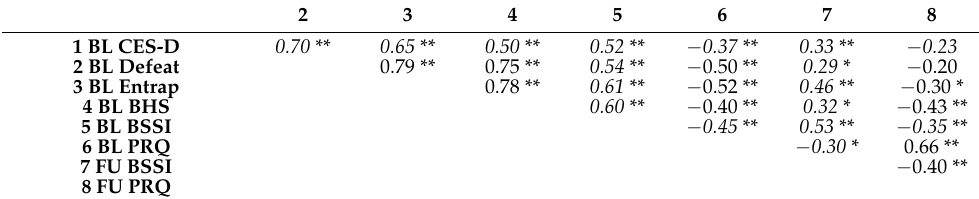
Table A1. Bivariate correlations between the key study variables at baseline and four-month follow-up.